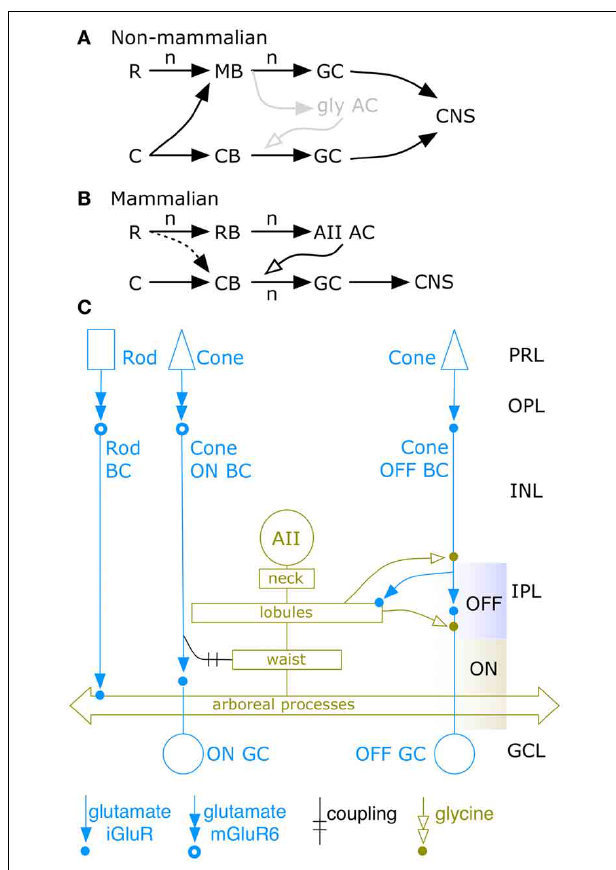
FIGURE 1 | Basic AII cell networks. Vertebrate rod R and cone C signal convergence patterns onto bipolar cells, amacrine or ganglion cells, and CNS targets. (A) Non-mammalian networks display two channel types: pure cone bipolar cell (CB) and mixed rod-cone bipolar cell (MB) channels that drive sets of retinal ganglion cells (GC) projecting to CNS targets via high gain (n) glutamate signaling (black arrows). The non-mammalian rod to GC chain has a net gain of n 2 . (B) Mammalian networks display separate CB and rod bipolar cell (RB) channels. Only CB channels drive GCs. RB channels drive only amacrine cells (ACs), in particular the AII AC that provides low gain coupling or glycinergic signaling (open arrow) from the third stage back to stage two in the CB chain. The mammalian rod to GC chain has a net gain of n 3 . There is evidence for sparse rod signal leakage into the CB chain. The gray glycinergic (gly) motif in (A) is the hypothetical evolutionary precursor of the mammalian AII AC. (C) The classic AII amacrine cell network, circa 1992. The rod input is collected by rod bipolar cells (Rod BC) which drive AII cells by ionotropic glutamate receptors (iGluRs). Cone input is collected by OFF cone bipolar cells (OFF BC) that also sparsely drive AII cells by iGluRs. The AII network is extensively coupled to ON cone bipolar cells. Glycinergic output from the AII network targets OFF BCs and OFF ganglion cells (OFF